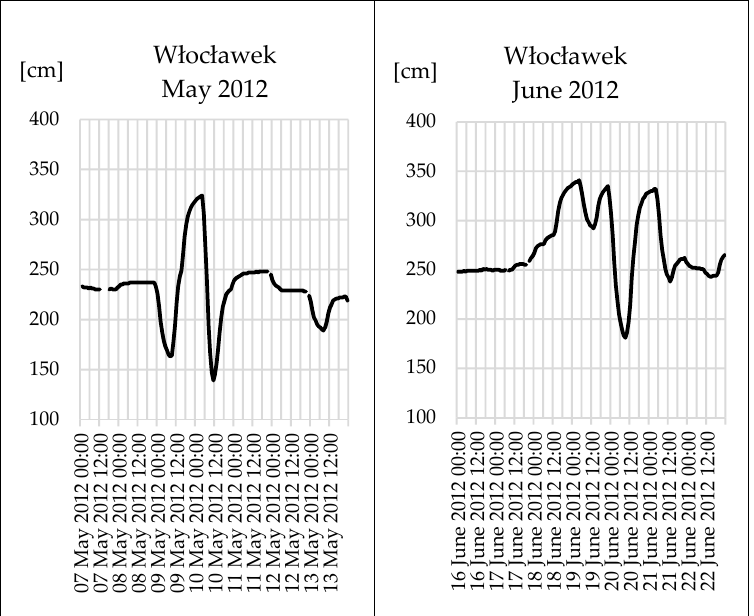
Figure 5. Water levels at the W ł oc ł awek water gauge during emergency discharge from the dam in W ł oc ł awek. Own elaboration. Source: www.pogodynka.pl.